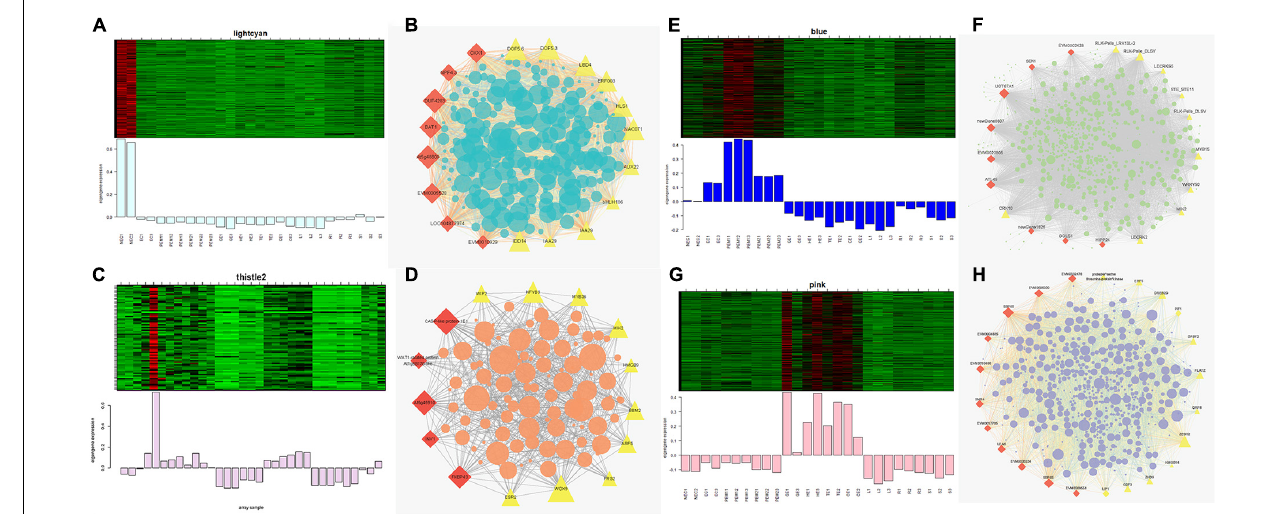
FIGURE 7 | Expression profile and transcriptional regulatory network associated with the tissue-specific modules. Heatmaps of (A) lightcyan module (NEC), (C) thistle modules (EC), (E) blue module (early SE), (G) pink module (somatic embryo development stages) show the expression profile of all the coexpressed genes in the modules (labeled on top). The color scale represents Z-score. Bar graphs (below the heat maps) show the consensus expression pattern of the coexpressed genes in each module. (B) Correlation network of genes in lightcyan module (NEC). (D) Correlation network of genes in thistle module (EC). (F) Correlation network of genes in blue module (early SE). (H) Correlation network of genes in pink module (somatic embryo development stages). Red diamonds indicate hub genes, and yellow triangles indicate transcription factors.